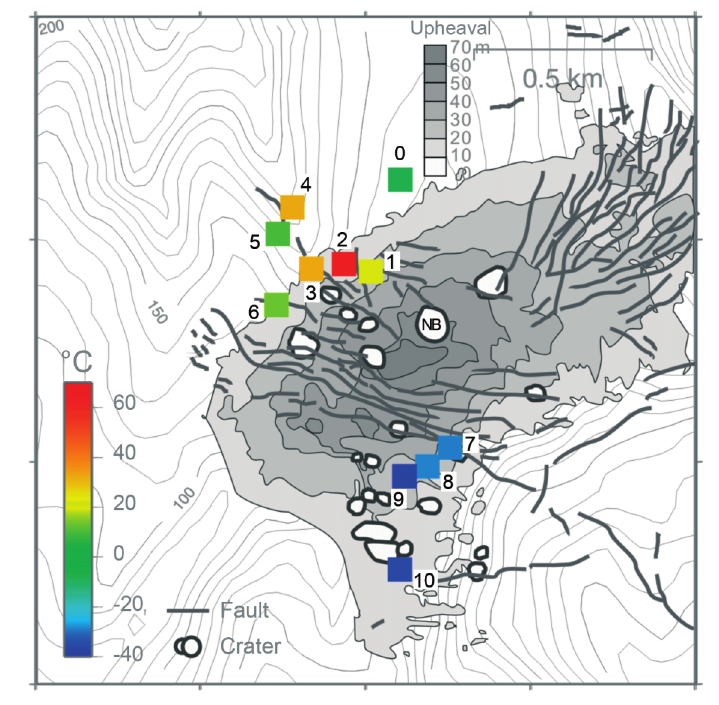
Fig. 4. Time difference of the ground temperature between March, 2002 and October-November,